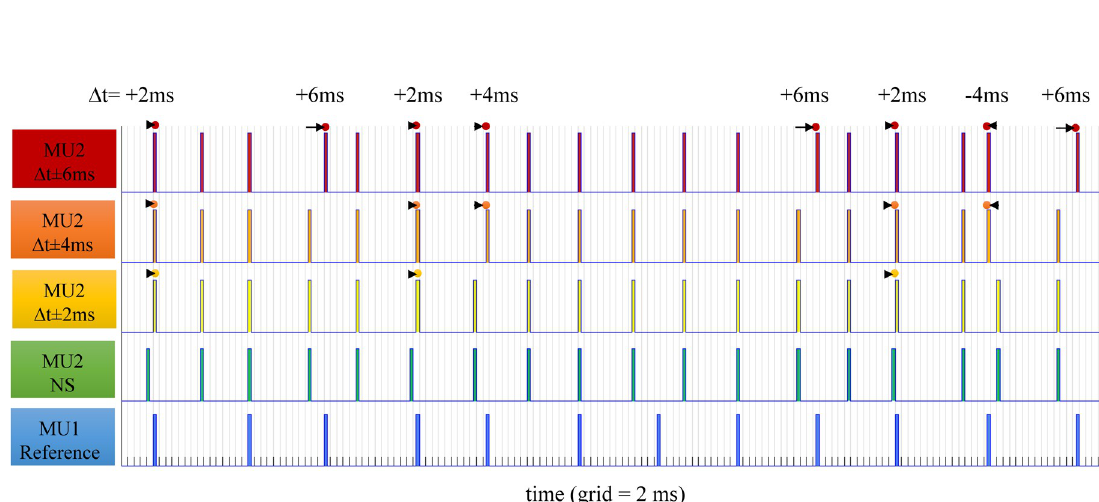
Fig 3. Illustration of the synchronization principle of basic MU firing patterns of two MUs, considering MU1 as a reference one (blue, bottom) and applying the synchronization of pulses to MU2 (green, NS ). Three time windows were used: Δ t = ± 2 ms (yellow), ± 4 ms (orange), and ± 6 ms (red). The dots highlight individual pulses of MU2, which were shifted in time (left or right, as indicated by arrows) to coincide with reference impulses of MU1 when the time interval between the pair of impulses of MU2 and MU1 was less or equal than | Δ t |. The level of synchronization was proportional to Δ t , illustrated in this example by increasing numbers n of shifted impulses—namely, n = 3 for Δ t = ± 2 ms, n = 5 for Δ t = ± 4 ms, and n = 8 for Δ t = ± 6 ms.